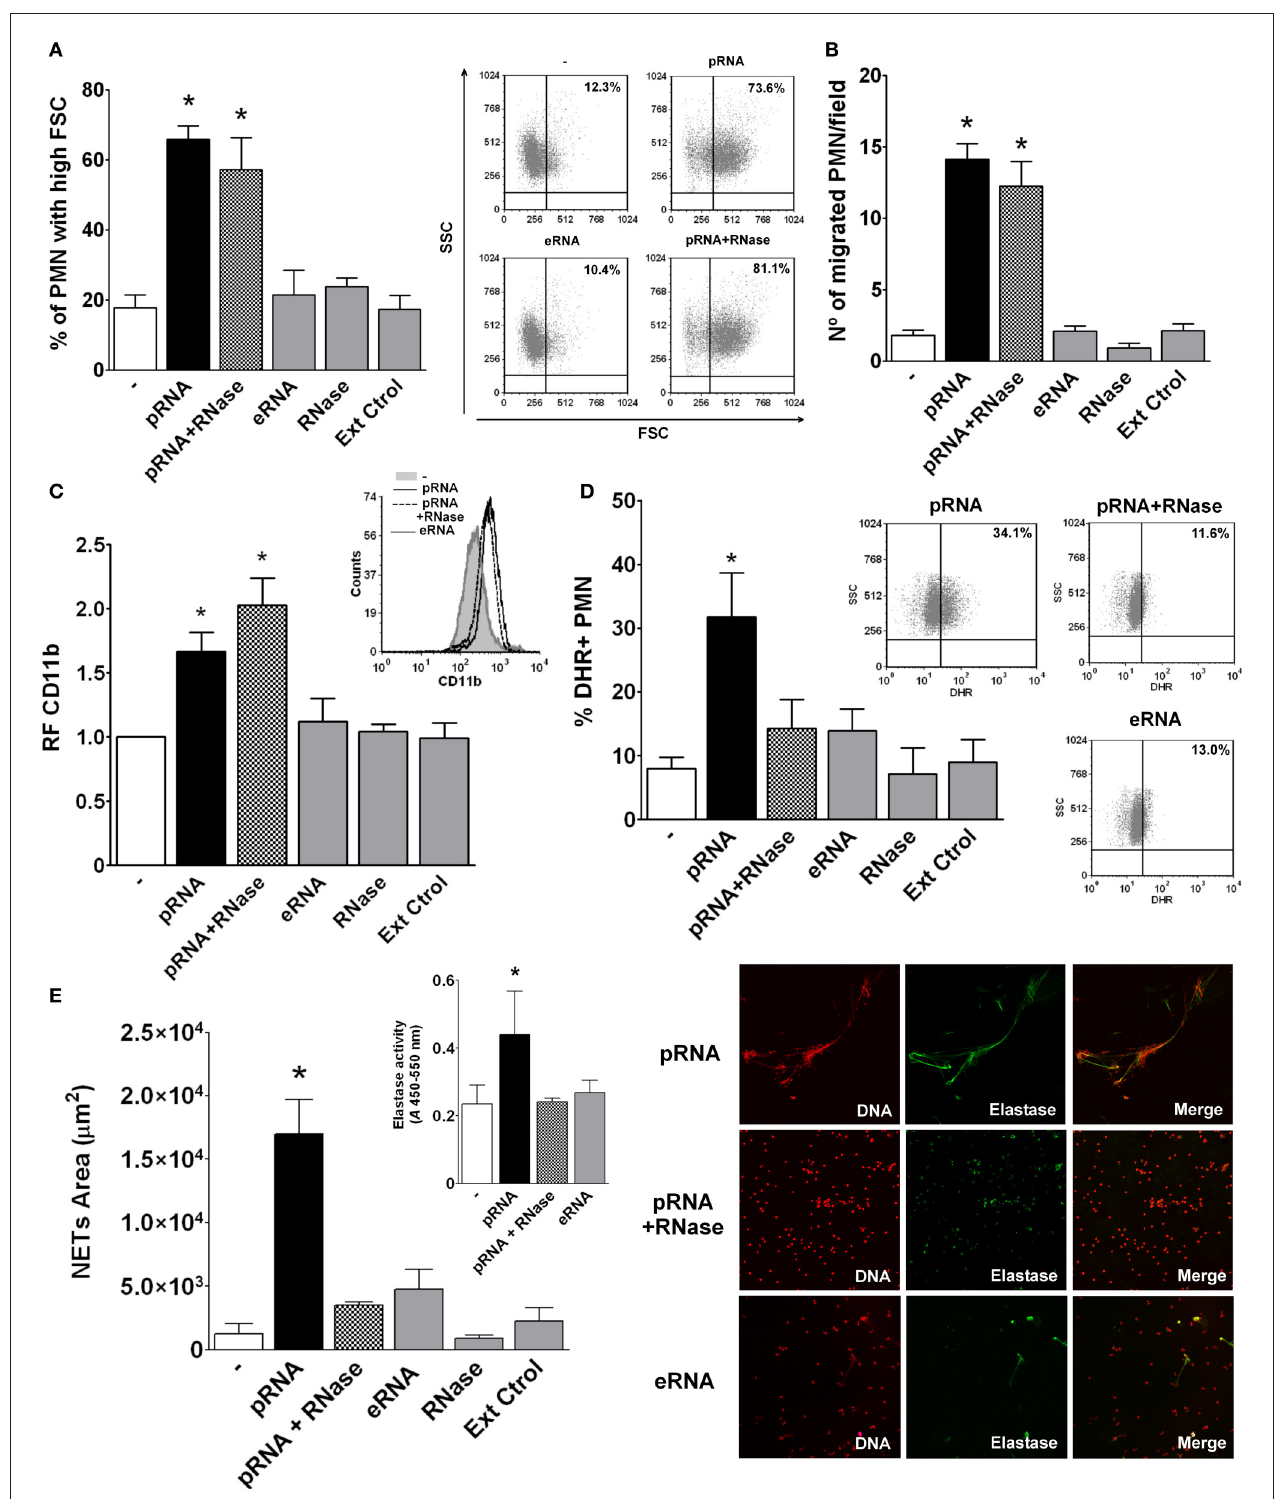
FIGURE 4 | Prokaryotic RNA (pRNA) directly activated PMN. Isolated PMN were treated with purified pRNA, eukaryotic RNA (eRNA), or pRNA treated with RNase. Controls of RNase alone or an extraction control (Ext Ctrol), using water instead of bacteria, were also included. (A) Percentage of PMN with high FSC. Results were expressed as the mean ± ES, n = 15. Right panel : representative dot-plots showing SSC vs. FSC profiles of PMN with no treatment ( − ), pRNA, eRNA, or